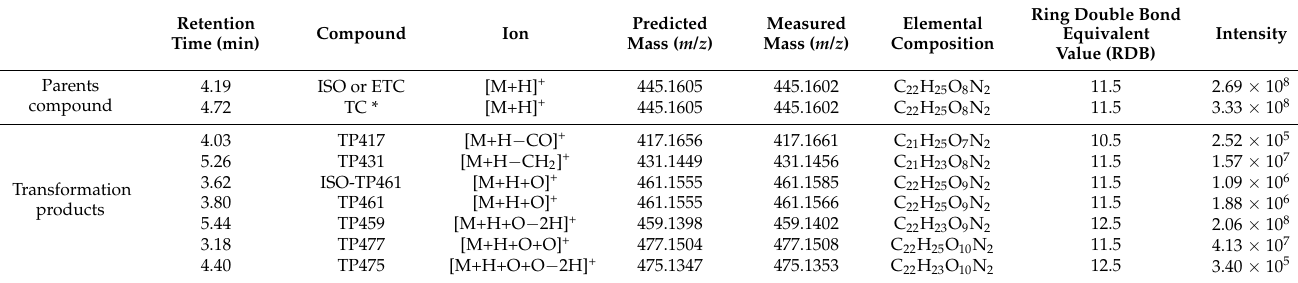
Ring Double Bond Predicted Measured Elemental Equivalent Intensity Mass ( m / z ) Mass ( m / z ) Composition Value (RDB)